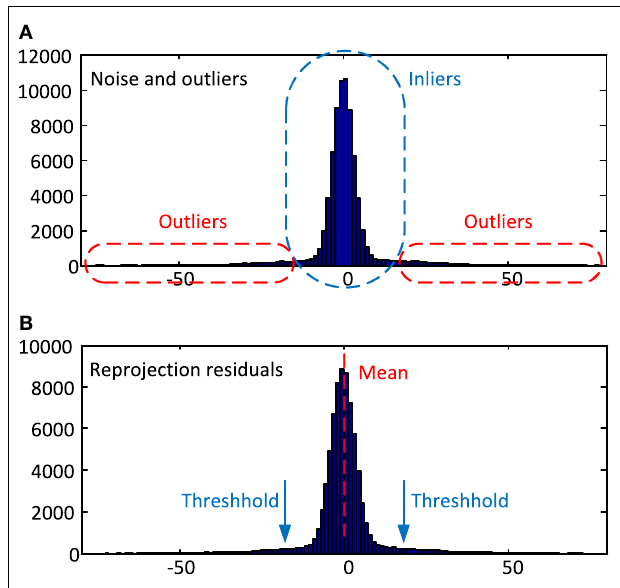
FIGURE 2 | (A) Histogram distribution of the added noise and outliers; (B) histogram distribution of the reprojection residuals.